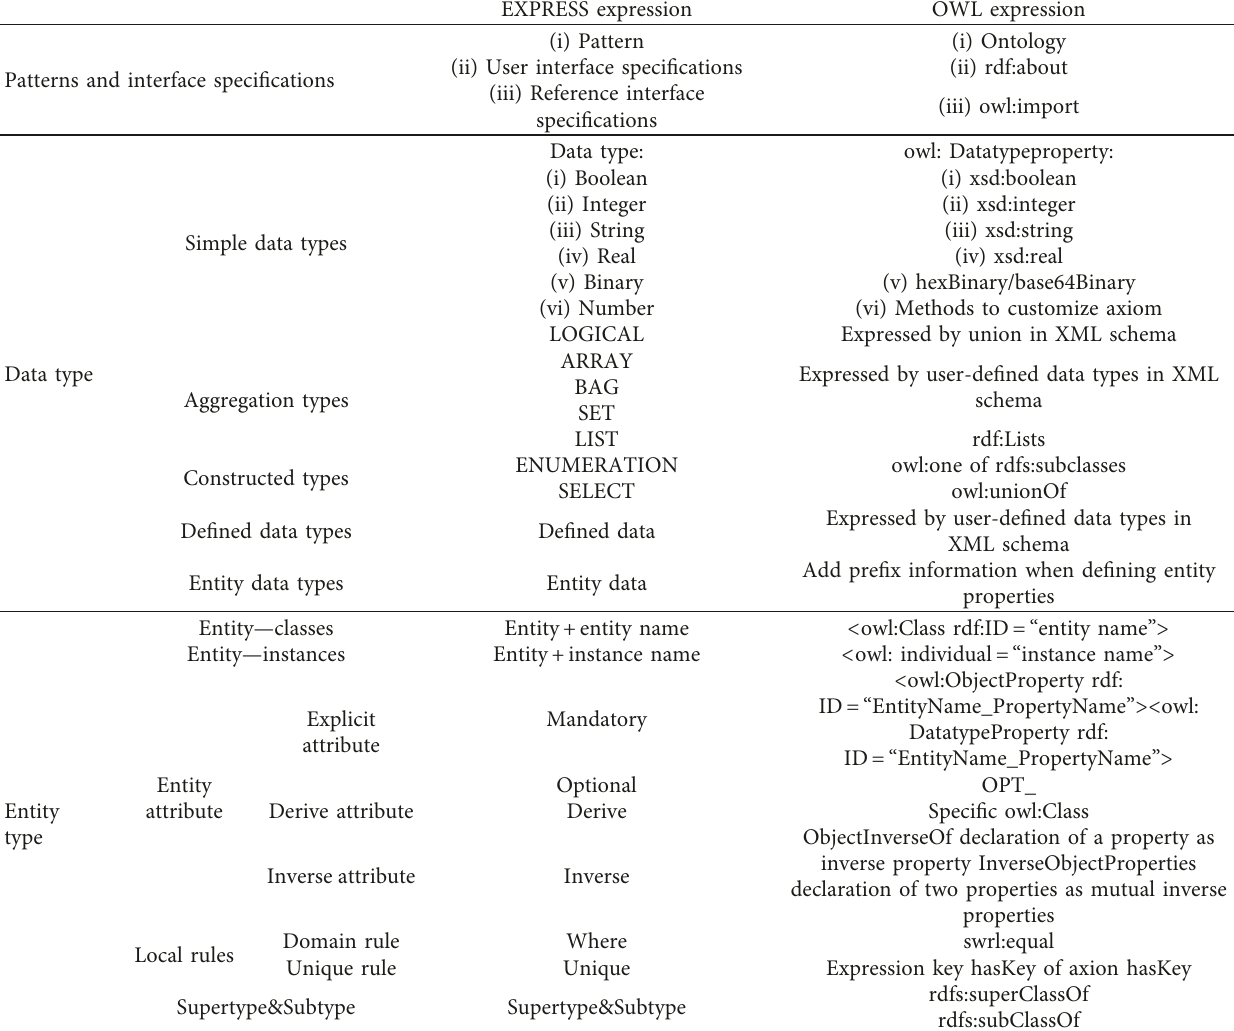
Table 3: Mapping between EXPRESS language and OWL language. EXPRESS